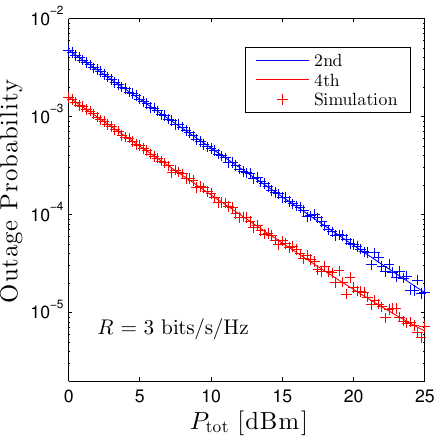
Figure 4. Outage probability vs. P tot under the path-loss based method. Solid lines are plotted by employing (12) and markers are Monte Carlo